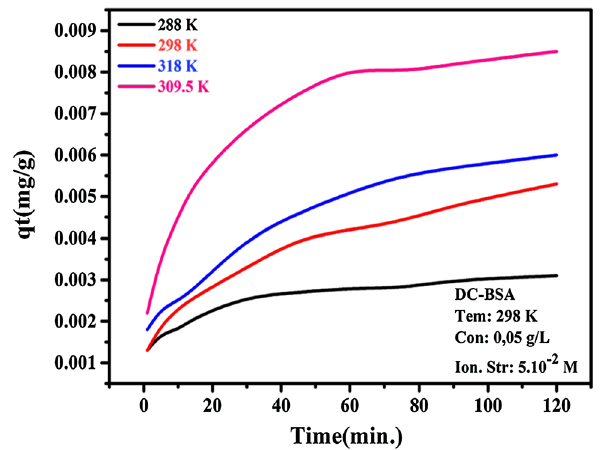
Fig. 6 Intraparticle diffusion plots for different